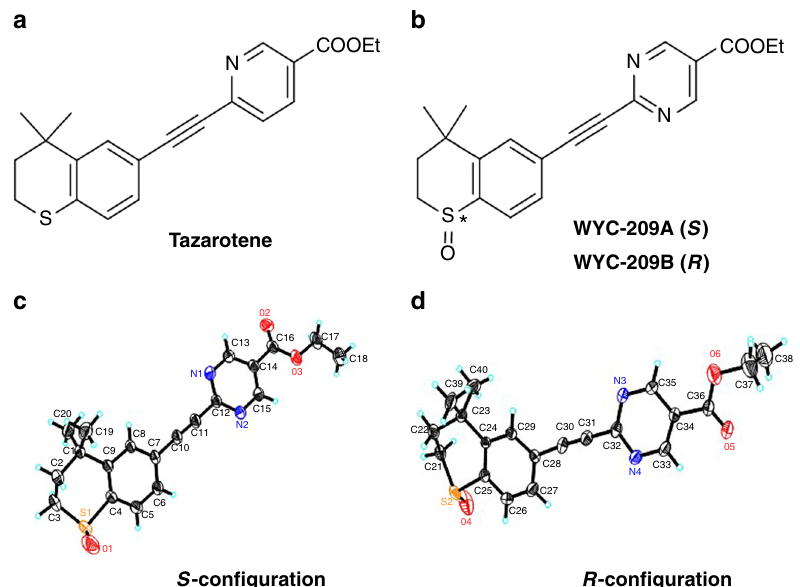
Fig. 1 Structures of Tazarotene and WYC-209 and X-ray crystal structures of WYC-209A and WYC-209B. a Structure of Tazarotene. b Structures of WYC-209A ( S ) and WYC-209B ( R ). c , d X-ray crystal structures of WYC-209A and WYC-209B. The con fi gurations of the sulfoxides were characterized by their crystal structures. Thermal ellipsoids were at 30% probability. Key bond lengths [Å] and angles [°]: S(1)-O(1) 1.422(7), S(1)-C(1) 1.768(8), S(1)-C (5) 1.791(6), S(2)-O(4) 1.447(6), S(2)-C(25) 1.802(7), S(2)-C(21) 1.831(10), O(1)-S(1)-C(1) 113.3(4), O(1)-S(1)-C(5) 108.4(4), C(1)-S(1)-C(5) 97.3(3), O(4)-S(2)-C(21) 99.2(5), O(4)-S(2)-C(25) 107.6(3), C(25)-S(2)-C(21)